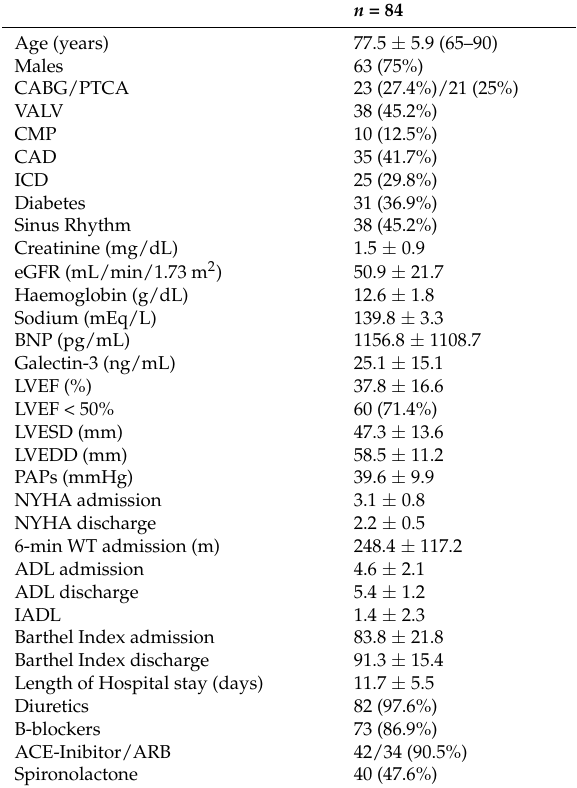
Table 1. General characteristics of the population examined.